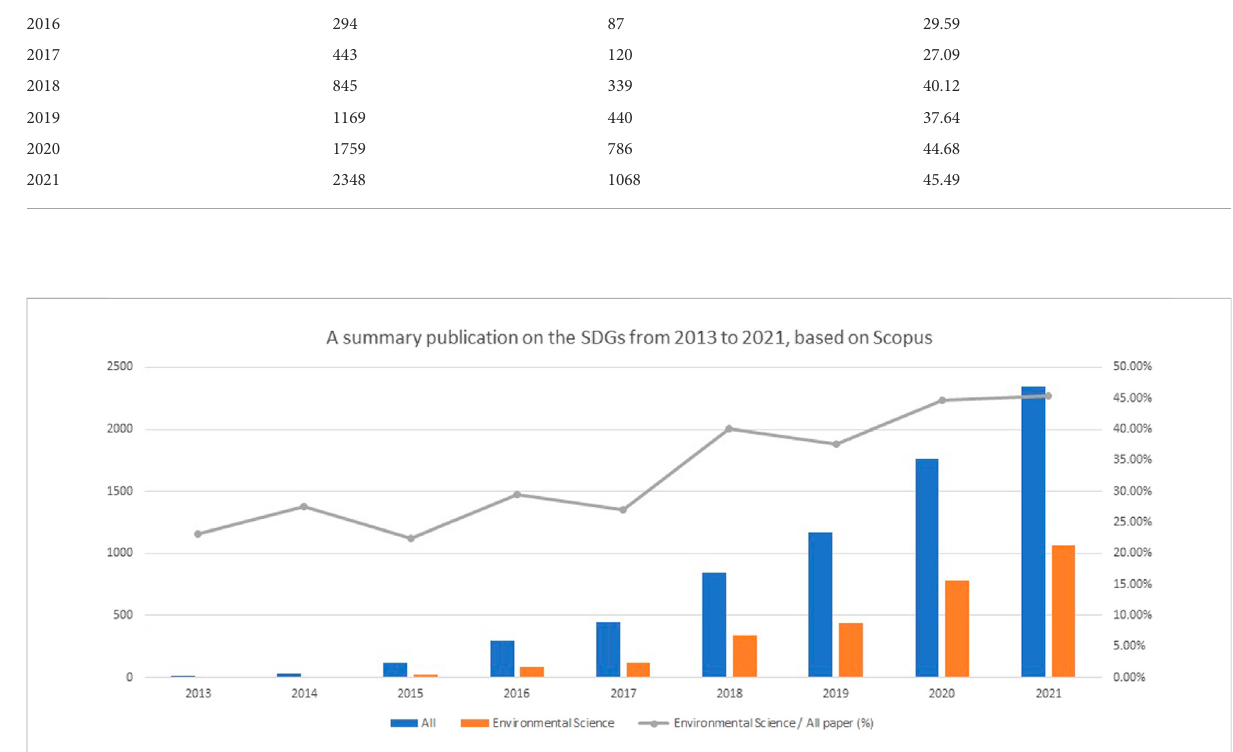
FIGURE 3 A summary publication on the SDGs from 2013 to 2021, based on